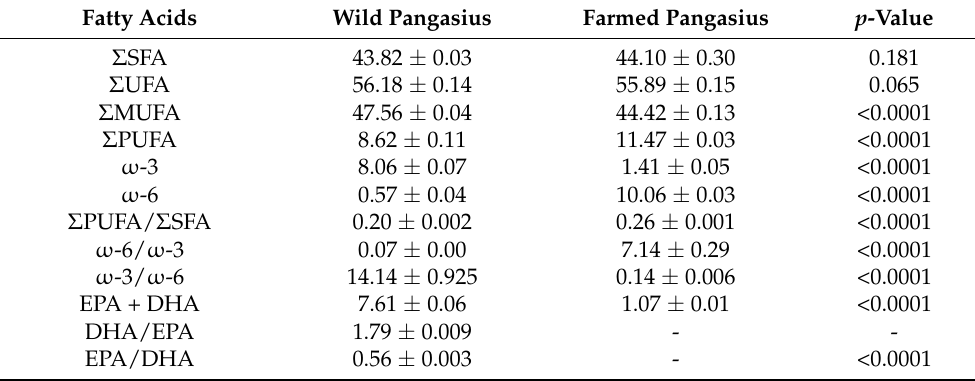
Table 5. Fatty acid profiles (g/100 g of total fatty acids; wet basis) and ratios estimated from lipids of the wild and the farmed pangasius catfish. Fatty Acids Wild Pangasius Farmed Pangasius p -Value Σ SFA 43.82 ± 0.03 44.10 ±